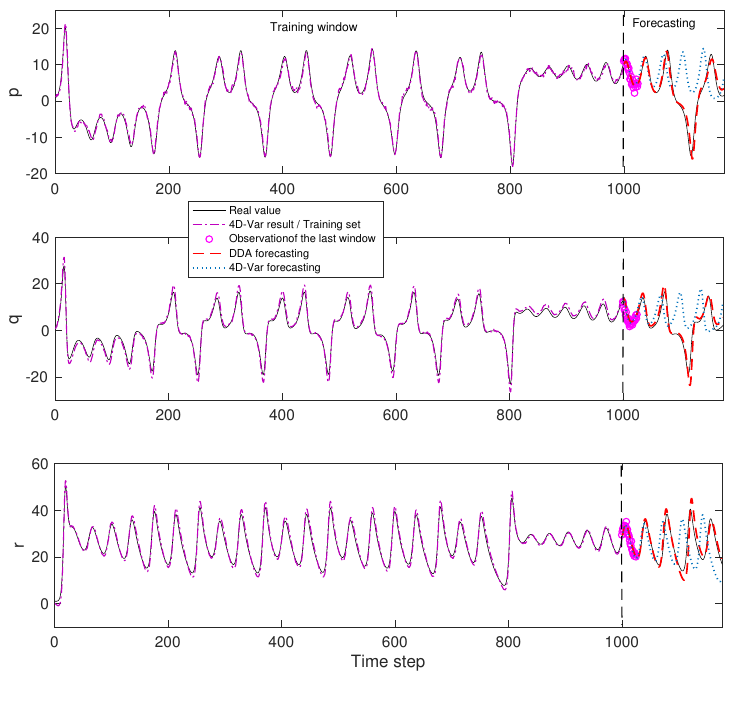
Figure 11. DA and DDA trajectories on 3 axis.